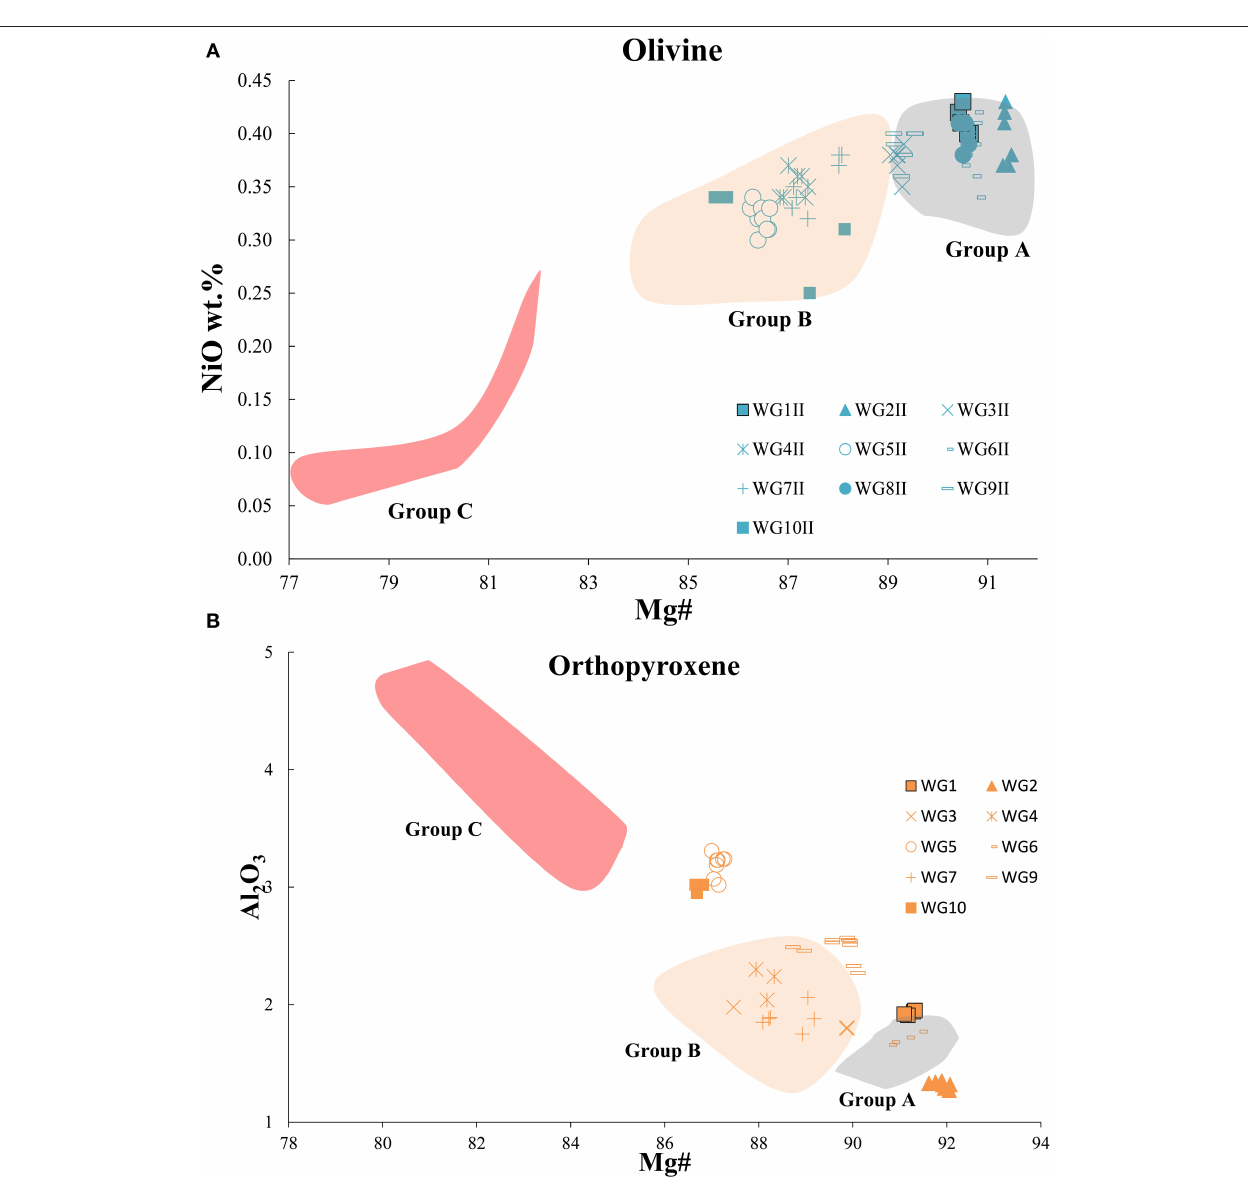
their primary character (Roedder, 1984); (2) secondary inclusions ( Figure S5D ) form clusters or trails that propagate from clinopyroxene (right part of S5D) to the recrystallized fine grained olivine (left part of S5D). We did not observe FI located along healed fractures. We consider secondary inclusions also trails of FI developed within Cpx and Opx, present e.g., as exsolution lamellae ( Figure S5E ), because trapped